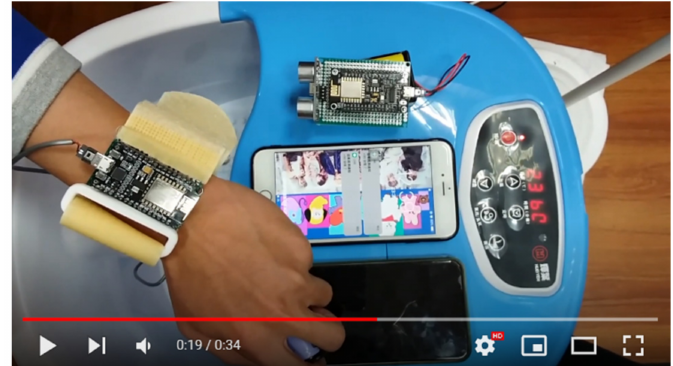
Figure 7. A demonstration for healthcare IoT devices using D-OTP